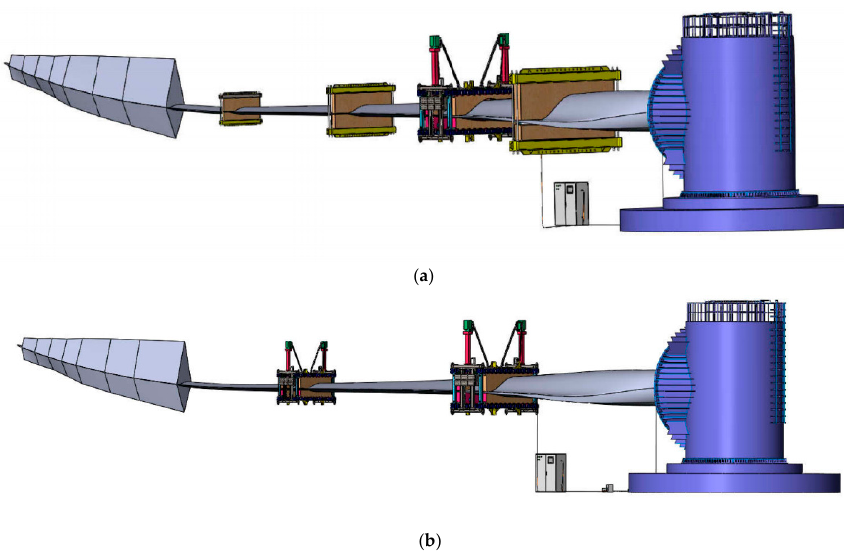
Figure 2. Comparison of multi-point excitation and single-point excitation system: ( a ) Single point excitation and tuning mass; ( b ) Multi-point excitation.